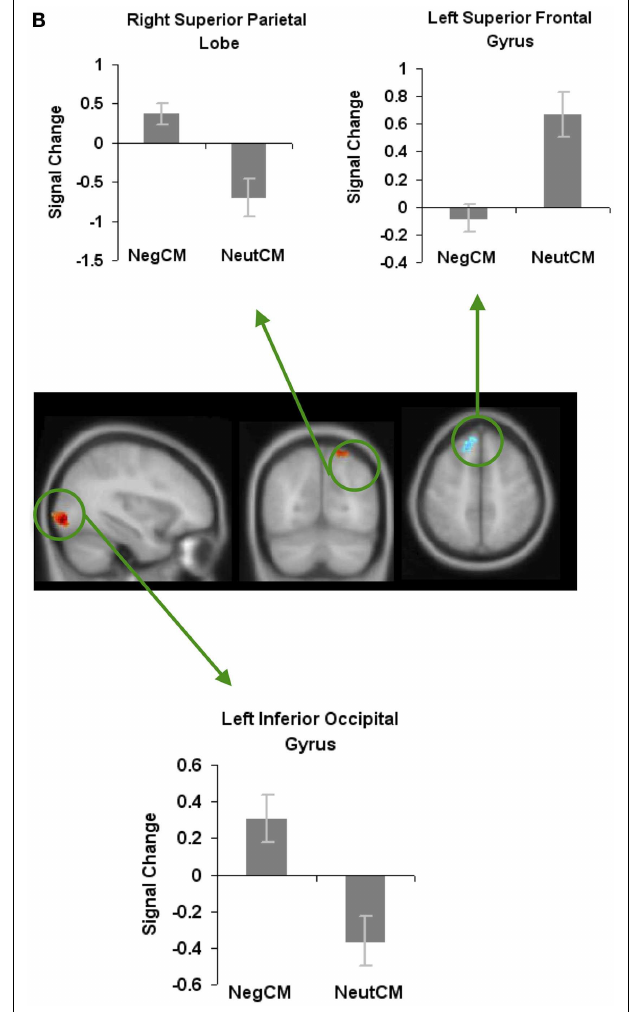
FIGURE 5 |Whole-brain activation showing signal change for the negatively valenced versus neutral metaphoric type-specific contrasts (A) reveals signal change for negatively valenced novel metaphors versus neutral novel metaphors and (B) reveals signal change for negatively valenced conventional metaphors versus neutral conventional metaphors . All clusters are illustrated at a threshold of p < 0.001 (uncorrected) combined with a cluster size of at least 50 voxels or 400mm 3 in volume. Mean beta weights for each condition extracted from the clusters illustrated in the specific contrasts of interest are revealed in the bar